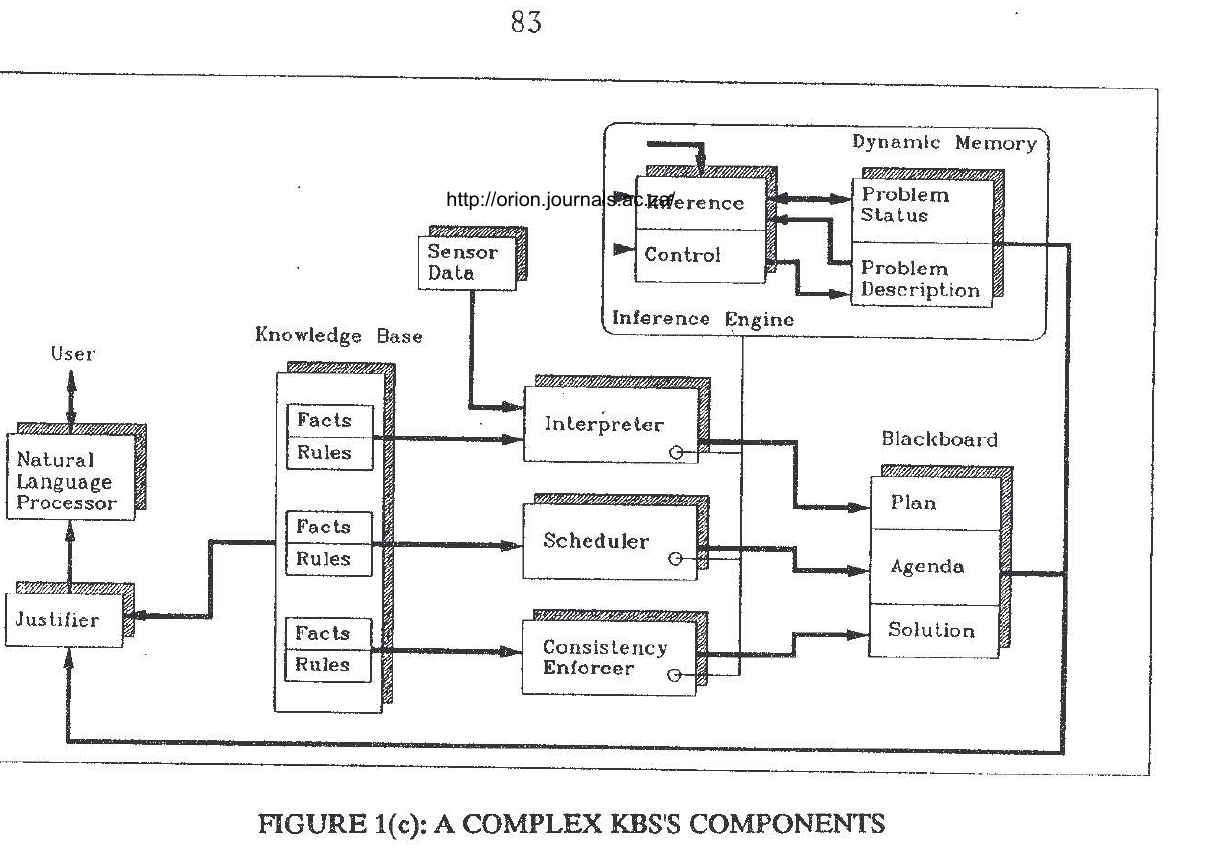
FIGURE l(c): A COMPLEX KBS'S